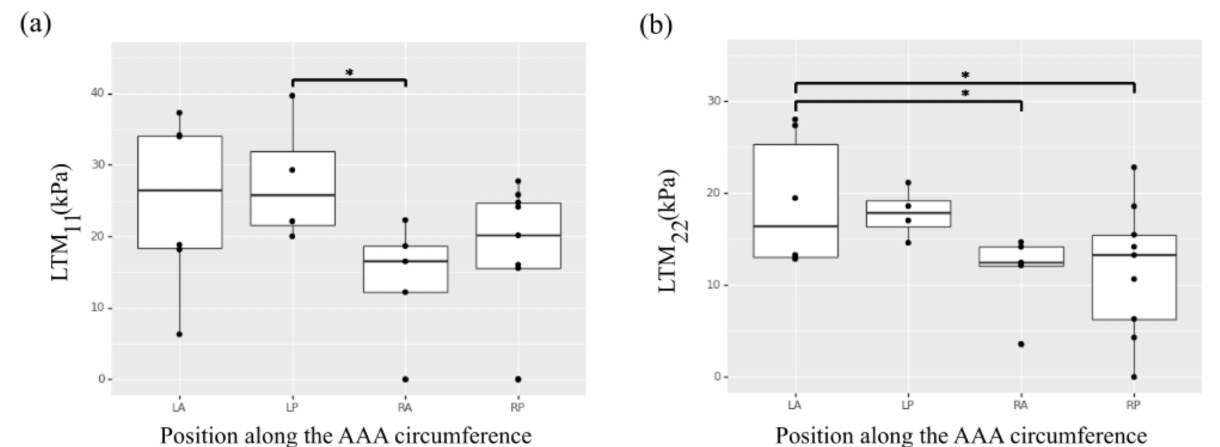
Figure 2. Heterogeneity of the selected ex vivo biaxial mechanical properties along the circumference of the AAA. ( a ) Low tangential modulus (LTM) in the circumferential direction (11). ( b ) Low tangential modulus (LTM) in the longitudinal direction (22). * indicates p value < 0.05.